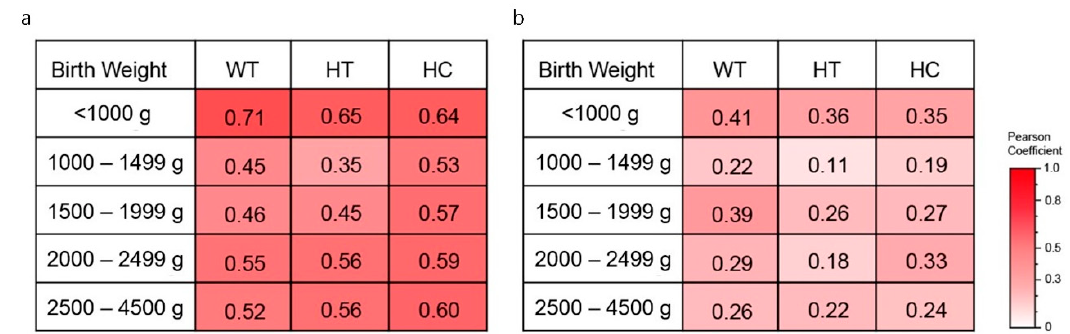
Figure 3. Pearson correlation coefficient between 6 months of age and 60 months of age for birth-weight groups among whole population ( a ) and among infants who were below the 10th percentile of height, weight, and HC at 60 months of age ( b ).